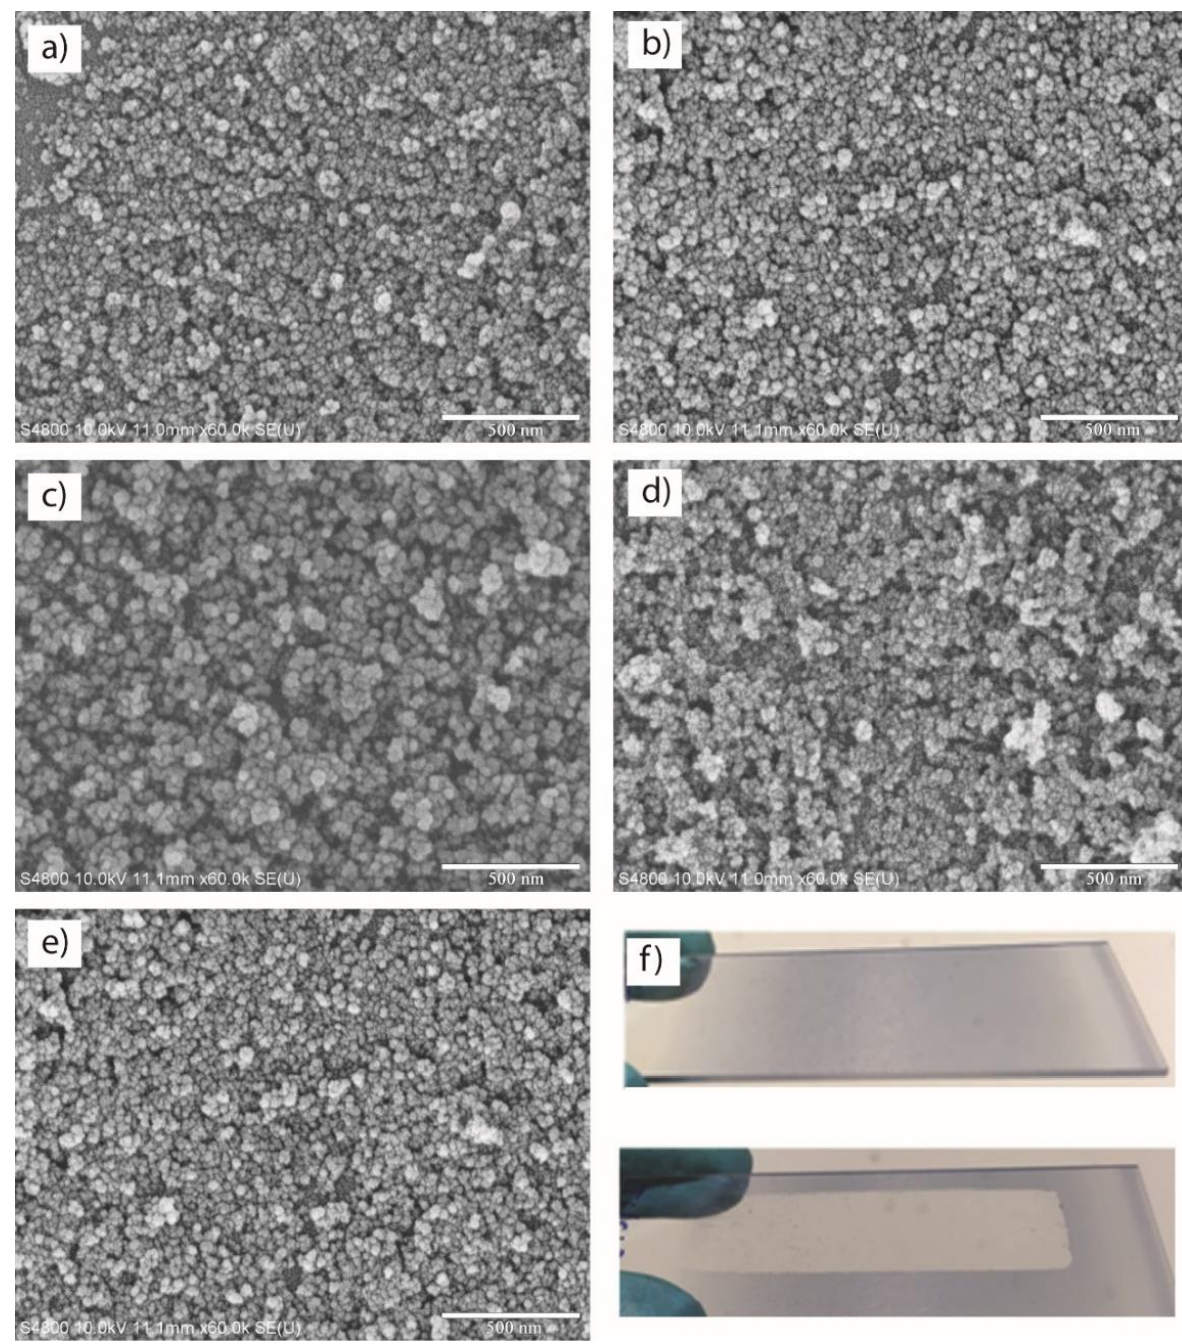
Figure 4. SEM images of ( a ) TiO 2 , ( b ) TiO 2 /SiO 2 99.5/0.5, ( c ) TiO 2 /SiO 2 99.0/1.0, ( d ) TiO 2 /SiO 2 97.0/3.0 and ( e ) TiO 2 /SiO 2 95.0/5.0 after tribological wear. Photographs of the nanoparticle deposited microscope glass before and after the tribological wear are shown in ( f ).